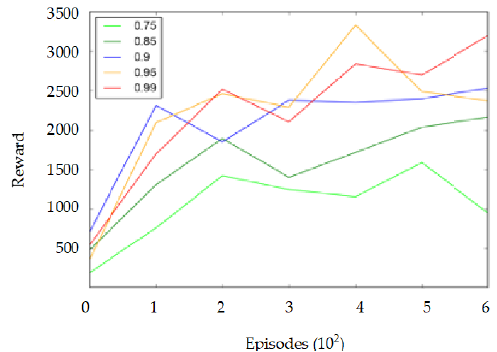
Figure 14. Average cumulative reward obtained by a DQN agent for different discount factor values in the Gazebo simulator.